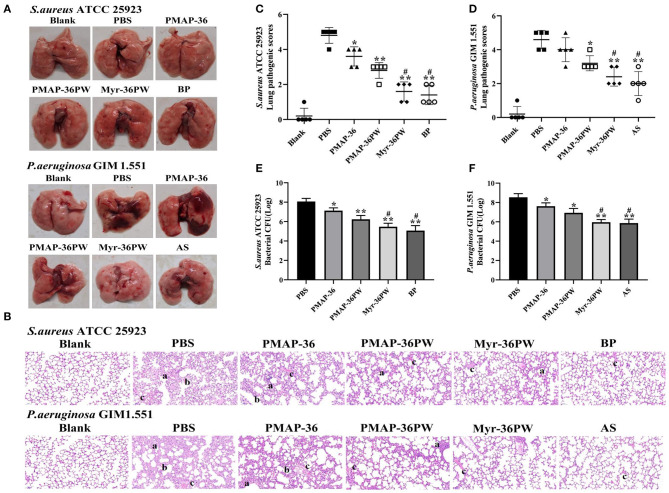
Therapeutic effect for pneumonia by Myr-36PW in vivo. Mice were injected with S. aureus ATCC 25923 or P. aeruginosa GIM 1.551 to form pneumonia, and lungs (n = 5) in each group were collected on day 4 after intranasal bacterial inoculation. (A) Morphological changes of lung tissues. (B) Representative histopathological images of processed lung section with hematoxylin and eosin (H&E) staining. Images are presented at a magnification of 20×. a: inflammatory cell infiltration. b: the alveolar wall is thickened. c: alveolar wall congestion or alveolar hemorrhage. (C,D) Pathological scores of the lung sections. Scoring standard: 1 indicated no pathology, 2 indicated local pulmonary congestion and inflammatory cell infiltration, 3 indicated pulmonary congestion and a large number of inflammatory cell infiltration, affecting <20% of the section, 4 indicated pulmonary congestion and a large number of inflammatory cell infiltration, affecting 20–50% of the section, and 5 indicated pulmonary congestion and a large number of inflammatory cell infiltration, affecting >50% of the section. (E,F) Bacterial CFU in lung homogenate. BP is benzylpenicillin potassium, AS is ampicillin sodium. Data represent the mean ± SD of five individual experiments. The number of bacteria (CFU) was displayed in the form of Log. *P < 0.05 and **P < 0.01, compared with PBS. #P < 0.05, compared with PMAP-36PW.